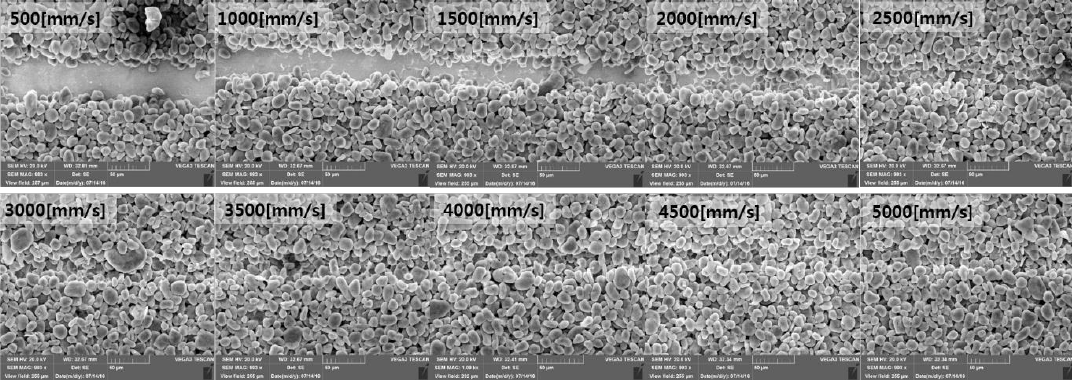
12 of 15 Figure 10. SEM images with a laser power of 150 W. Figure 11. SEM images with a laser power of 100 W. Figure